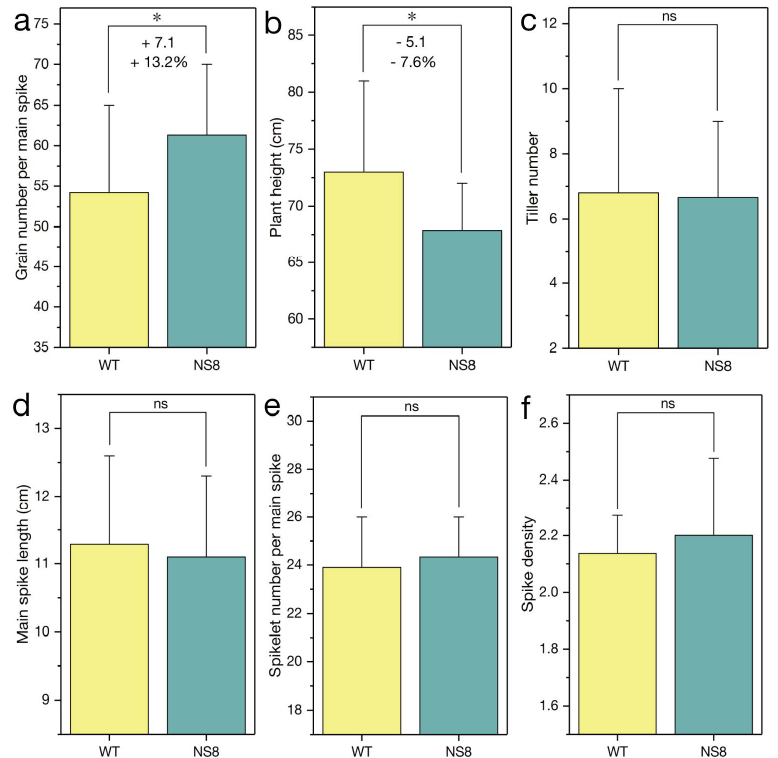
Figure 6. Effect of Q c1 -N8 on agronomic traits during the 2020–2021 growing season. The subfigures ( a – f ) are the comparisons of the grain number per main spike, plant height, tiller number, main spike length, spikelet number per main spike, and spike density of the WT and NS 8 samples, respectively. The data in the bar graphs are presented as the mean ± standard deviation. *, p < 0.05; ns, not significant. ‘+’ and ‘ − ’ indicate more and less than the wild-type (WT) control, respectively. ‘+7.1′ in panel ( a ) indicates NS 8 plants had 7.1 more grains per main spike than the WT plants (on average). ‘+13.2%’ in panel ( a ) indicates that Q c1 -N8 increased the grain number per main spike by 13.2% (on average).